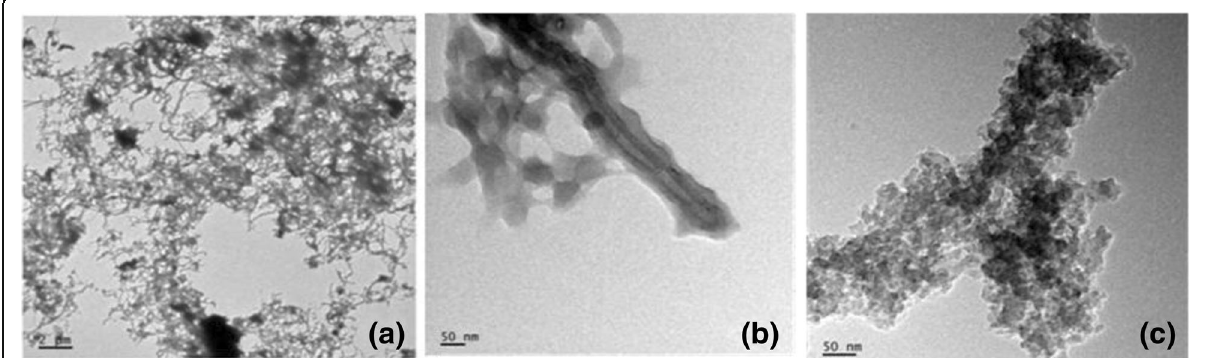
Fig. 4 TEM images of a MWCNT, b MWCNT-IIP, and c